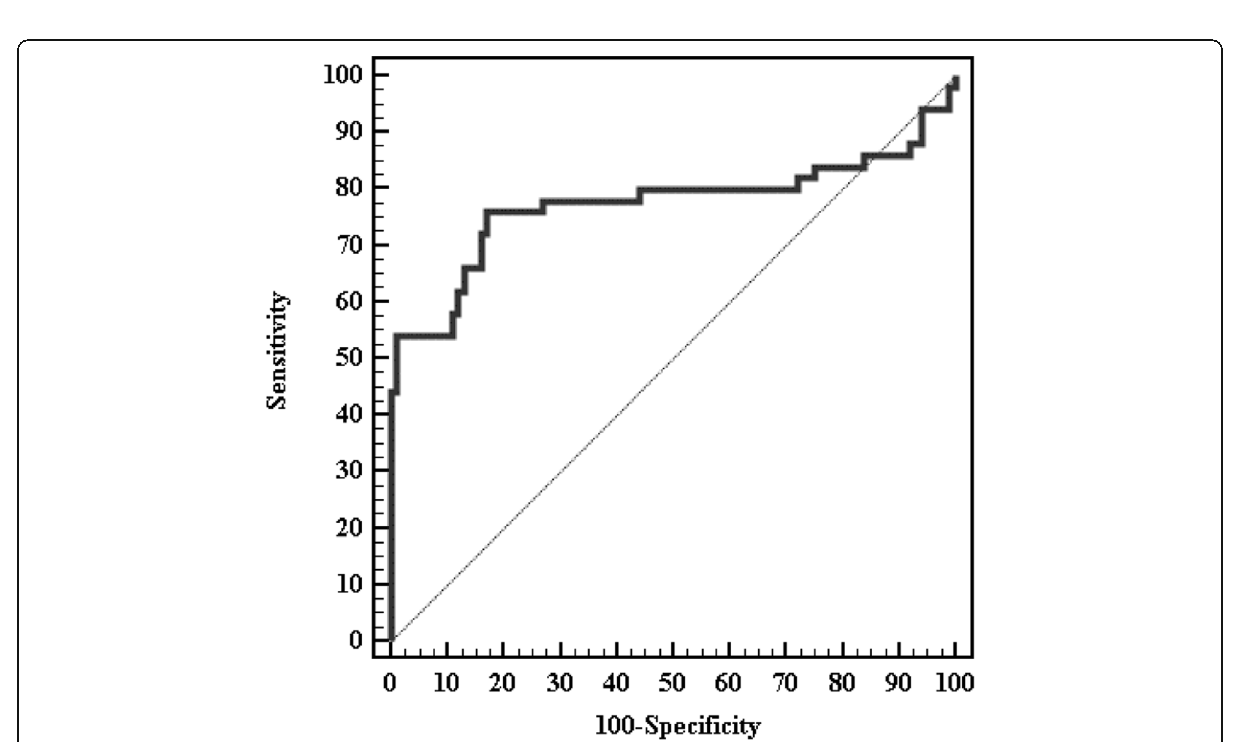
Fig. 6 ROC curve for the combination of AFP, miR-331-3p, and miR-23b-3p to predict early-stage HCC patients (group II) from HCV-related cirrhosis (group